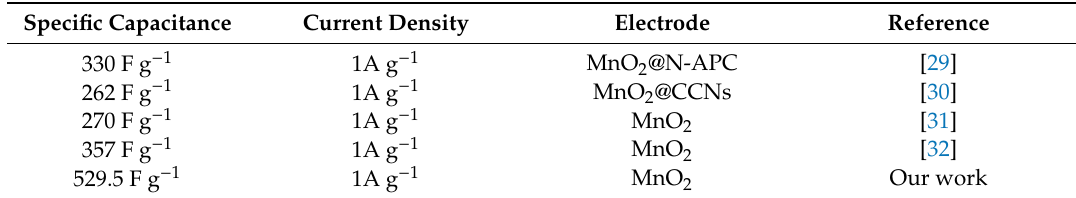
Table 1. Specific capacitance compared with others.